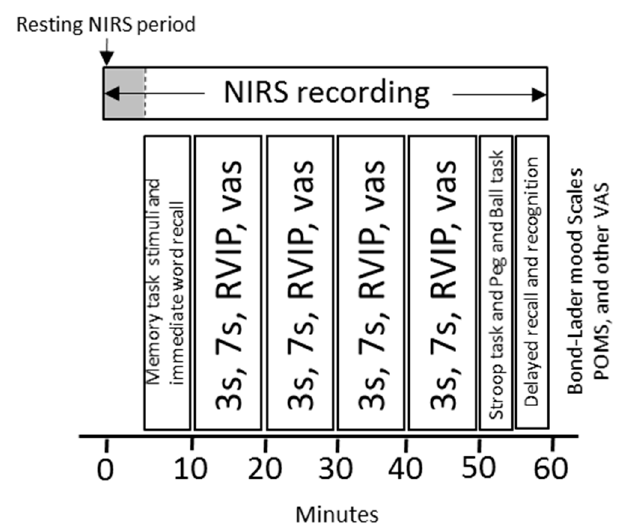
Figure 1. Cognitive and mood assessment with concurrent NIRS recording. 3 s, serial 3 subtractions; 7 s, serial 7 subtractions; RVIP, rapid visual information processing; VAS, visual analogue scales; POMS, Profile of Mood States questionnaire.